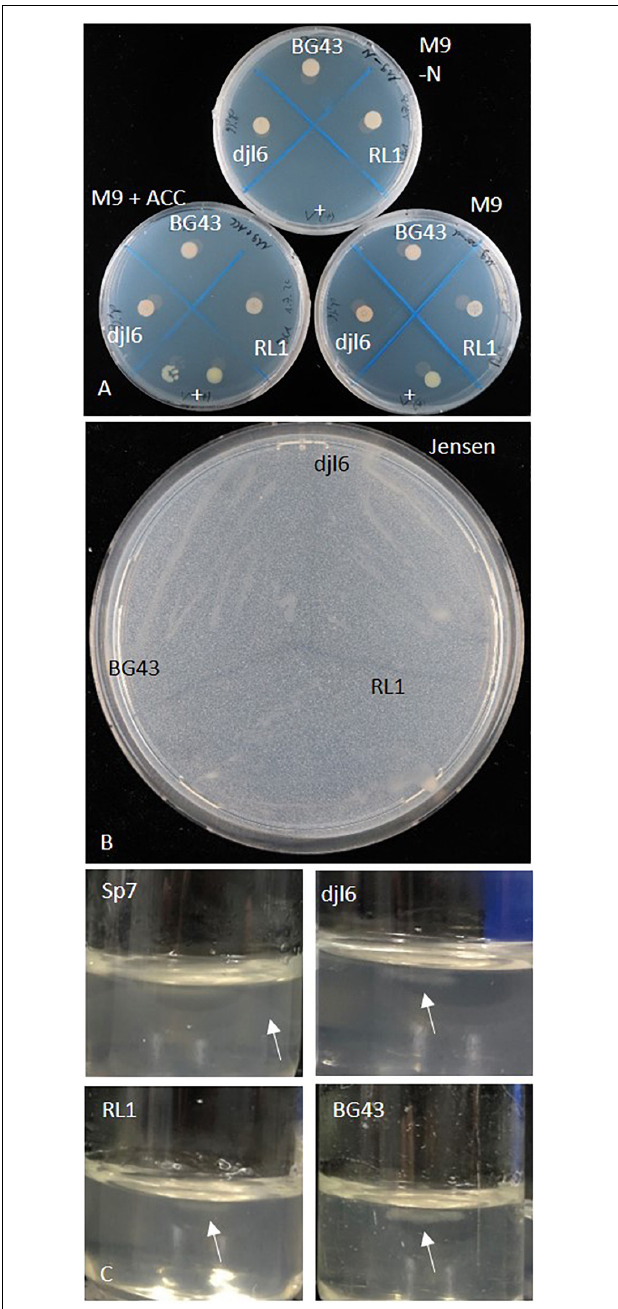
FIGURE 5 | Growth characterization of Rhodococcus strains RL1, djl6, and BG43 on various nitrogen-free media. (A) M9-N, M9 (control) and M9 + ACC, (B) Jensen’s medium, and (C) Nfb-semisolid medium (Döbereiner, 1995) Sp7 = Azospirillum brasilense Sp7 (positive control for nitrogen fixation), + = Variovorax sp. (positive control for ACC deaminase activity). Arrows mark pellicle formation.